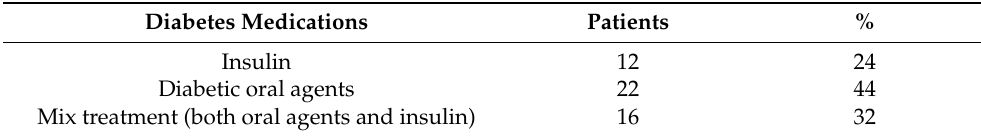
Table 1. Type of anti-diabetic medications. Diabetes